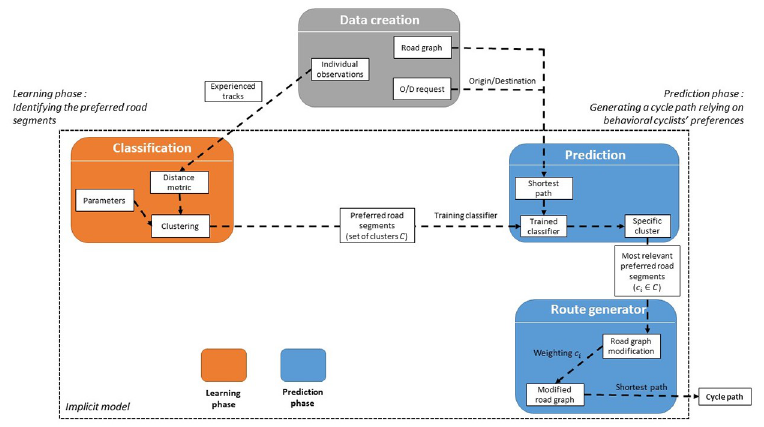
Fig 1. Diagram summarizing our bicycle implicit route choice